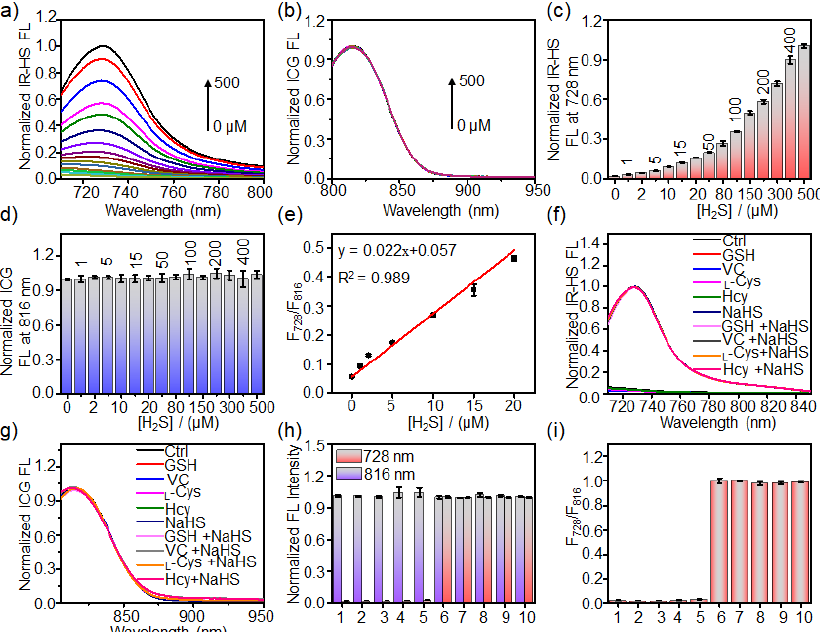
Figure 3. Study on the reactivity of HS-CG with H 2 S. ( a ) Fluorescence spectra of IR-HS and ( c ) change in the fluorescence intensity at 728 nm of IR-HS within HS- CG (5/5 μM IR -HS/ICG) upon incubation with NaHS (0, 1, 2, 5, 10, 15, 20, 50, 80, 100, 150, 200, 300, 400, 500 μM) in PBS buffer (pH 7.4) at 37 °C for 6 min. ( b ) Fluorescence spectra of ICG and ( d ) change in the fluorescence intensity at 816 nm of ICG within HS- CG (5/5 μM IR -HS/ICG) upon incubation with NaHS (0, 1, 2, 5, 10, 15, 20, 50, 80, 100, 150, 200, 300, 400, 500 μM) in PBS buffer (pH 7.4) at 37 °C for 6 min. ( e ) The linear relationship between the F 728 /F 816 and the concentration of NaHS from 0 to 20 μM. Fluorescence spectra of ( f ) IR-HS and ( g ) ICG within HS- CG (5/5 μM IR -HS/ICG), ( h ) fluorescence intensities of HS-CG at 728 and 816 nm, and ( i ) F 728 /F 816 of HS-CG upon incubation with different reagents (1 — Ctrl, 2 — 5 mM glutathione (GSH), 3 — 1 mM ascorbic acid (VC), 4 — 1 mM L-cysteine ( L -Cys), 5 — 1